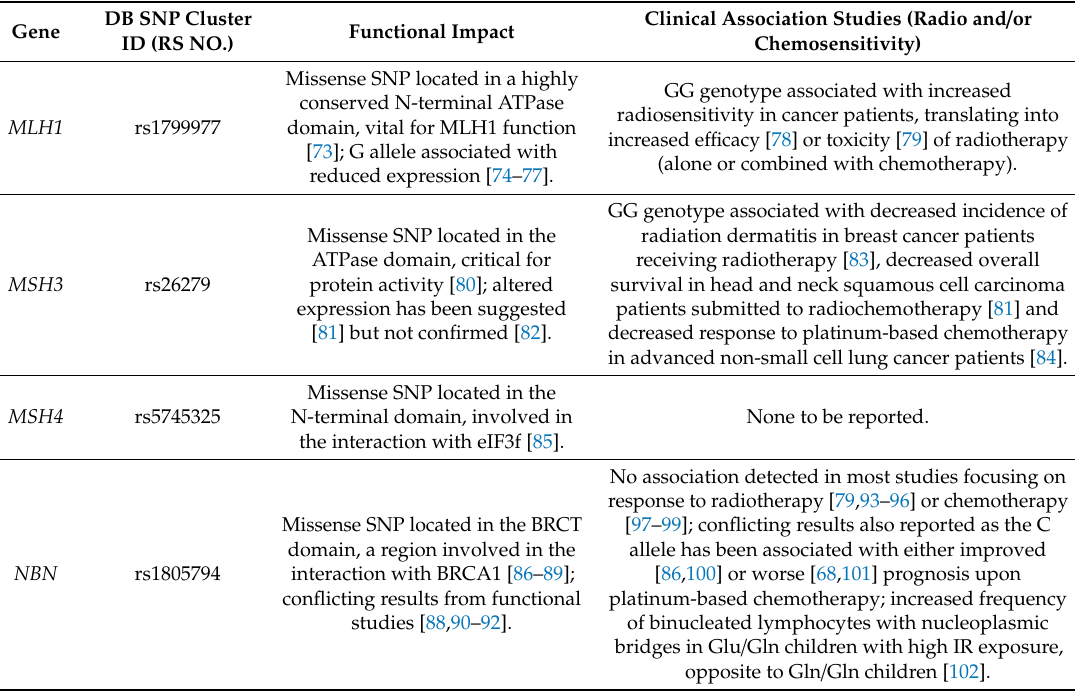
Table 6. Literature review on the functional impact of the studied SNPs and their putative association with radio and / or chemosensitivity (only SNPs presenting significant findings in the present study are